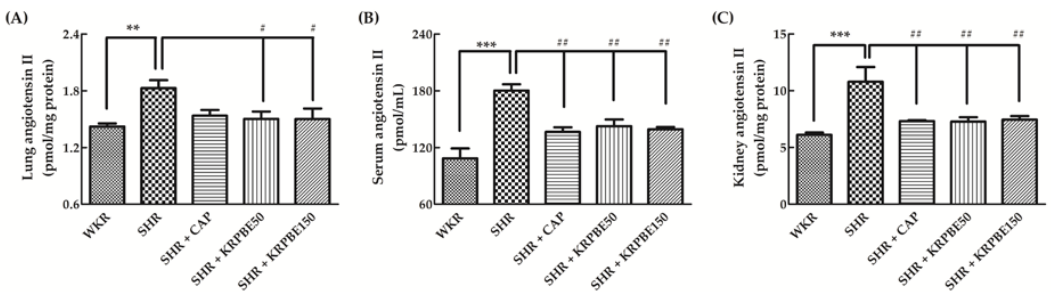
Figure 3. Angiotensin II content in lungs ( A ), serum ( B ), and kidneys ( C ) of WKRs and SHRs after seven weeks of oral administration. WKR group (tap water), SHR group (tap water), SHR + CAP group (15 mg/kg body weight/day of CAP), SHR + KRPBE50 group (50 mg/kg body weight/day of KRPBE), and SHR + KRPBE150 group (150 mg/kg body weight/day of KRPBE) were orally administrated for seven weeks. Each group consists of six rats. Tukey-Kramer honestly significant di ff erence test: ** p < 0.01, *** p < 0.001 vs. WKR and # p < 0.05, ## p < 0.01 vs. SHR.